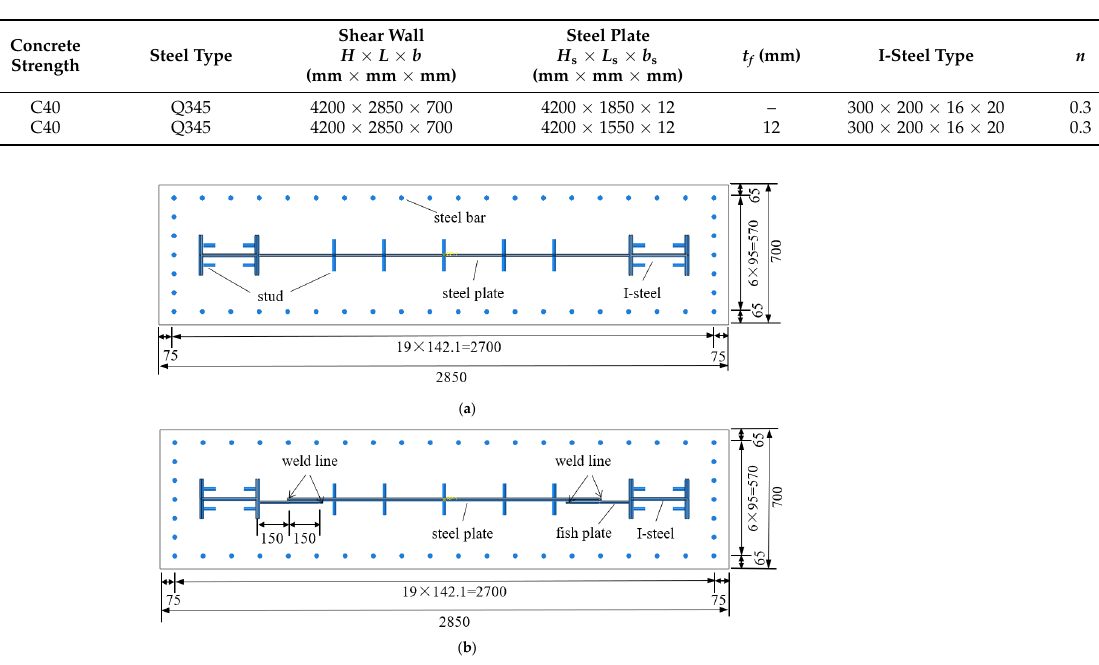
Table 1. Main parameters of shear wall models.